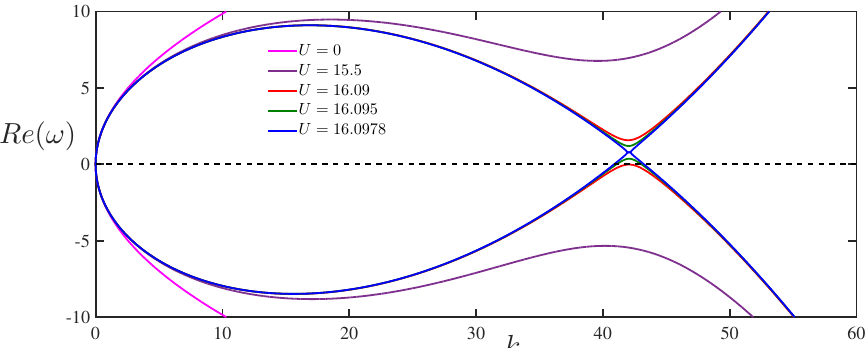
Figure 2. Graphics of the dispersion relations ω 1 ( k ) (upper branches) and ω 2 ( k ) (lower branches) for the ice parameters presented above – see after Equation (5); the values of U are shown in m/s. On the other hand, the dispersion curves become non-symmetric for U (cid:54) = 0 due to the wave drift induced by flow. Further, the lower branch of the dispersion curves changes < k < k (cid:48) it sign and become positive in the interval k (cid:48) for U > U c 1 (= 16.09 ) m/s. This 2 1 is illustrated in Figure 3 for U = 16.095 m/s, which represents the magnified portion of Figure